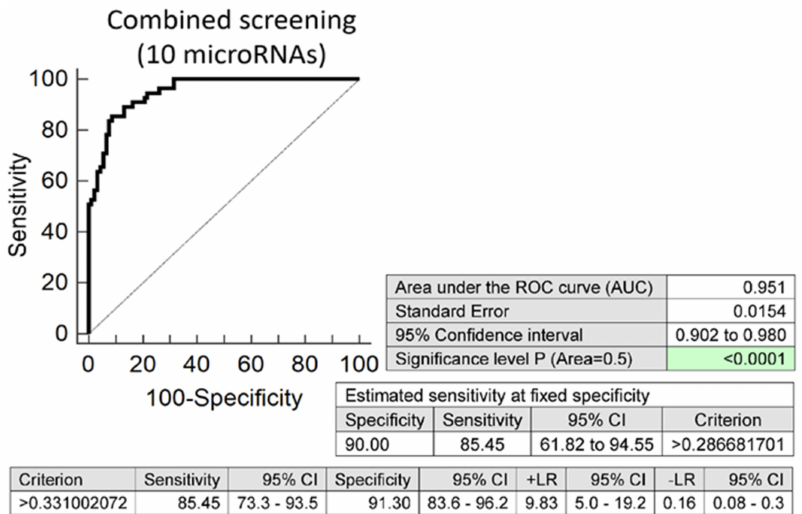
Figure 1. Altered postnatal microRNA expression profile in children descending from PPROM preg- nancies. Combined screening of 10 selected microRNAs with the best sensitivity (miR-1-3p, miR-20a-5p, miR-20b-5p, miR-26a-5p, miR-100-5p, miR-103a-3p, miR-126-3p, miR-143-3p, miR-195-5p, and miR-499a-5p) reveals 85.45% children with a potential cardiovascular risk at 10.0%